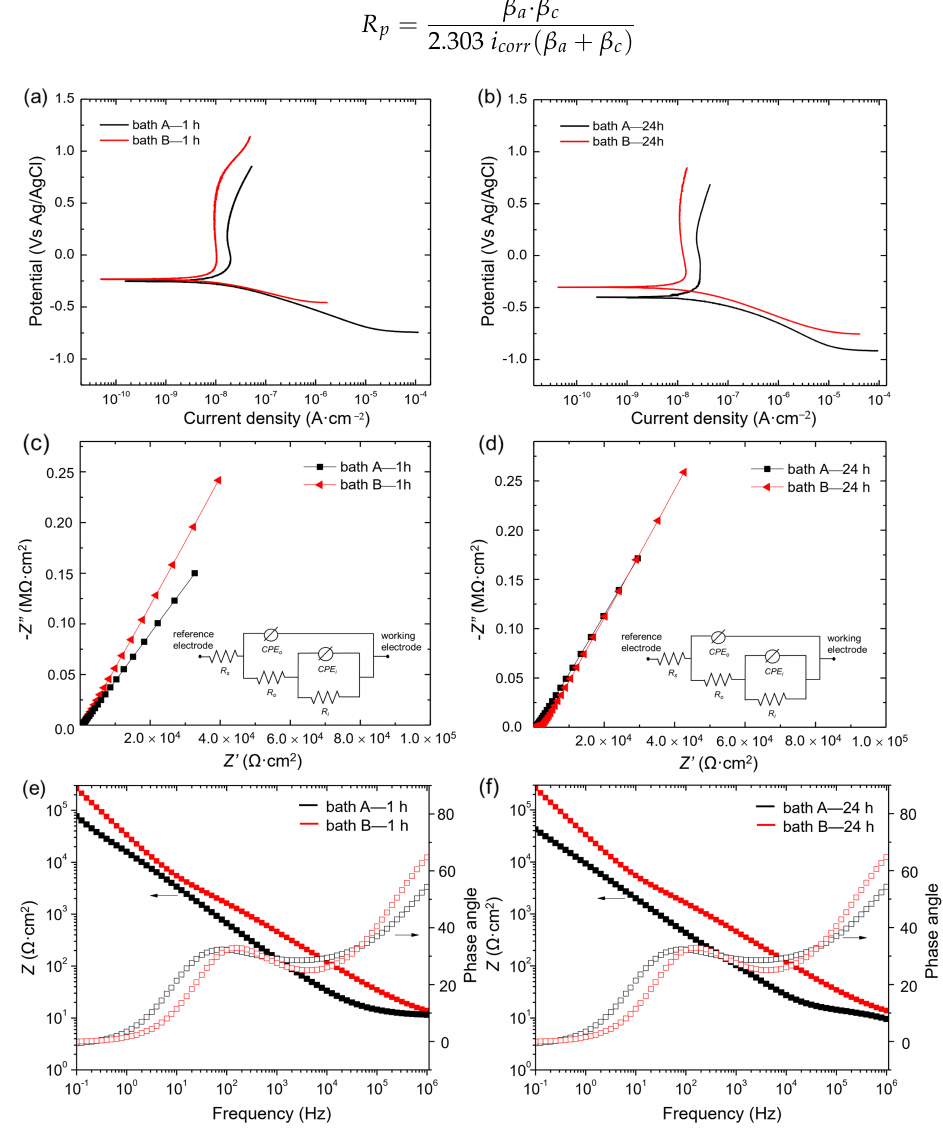
Figure 6. ( a , b ) Potentiodynamic polarization curves of the PEO–treated samples after immersion in 3.5 wt.% NaCl for 1 h, 24 h, respectively. The bath B sample showed better corrosion protection in both short and long corrosion tests. ( c , d ) EIS Nyquist plots and ( e , f ) Bode plots of all samples measured from 10 6 to 0.1 Hz. The values were acquired based on the equivalent circuit model, shown as insets in ( c , d